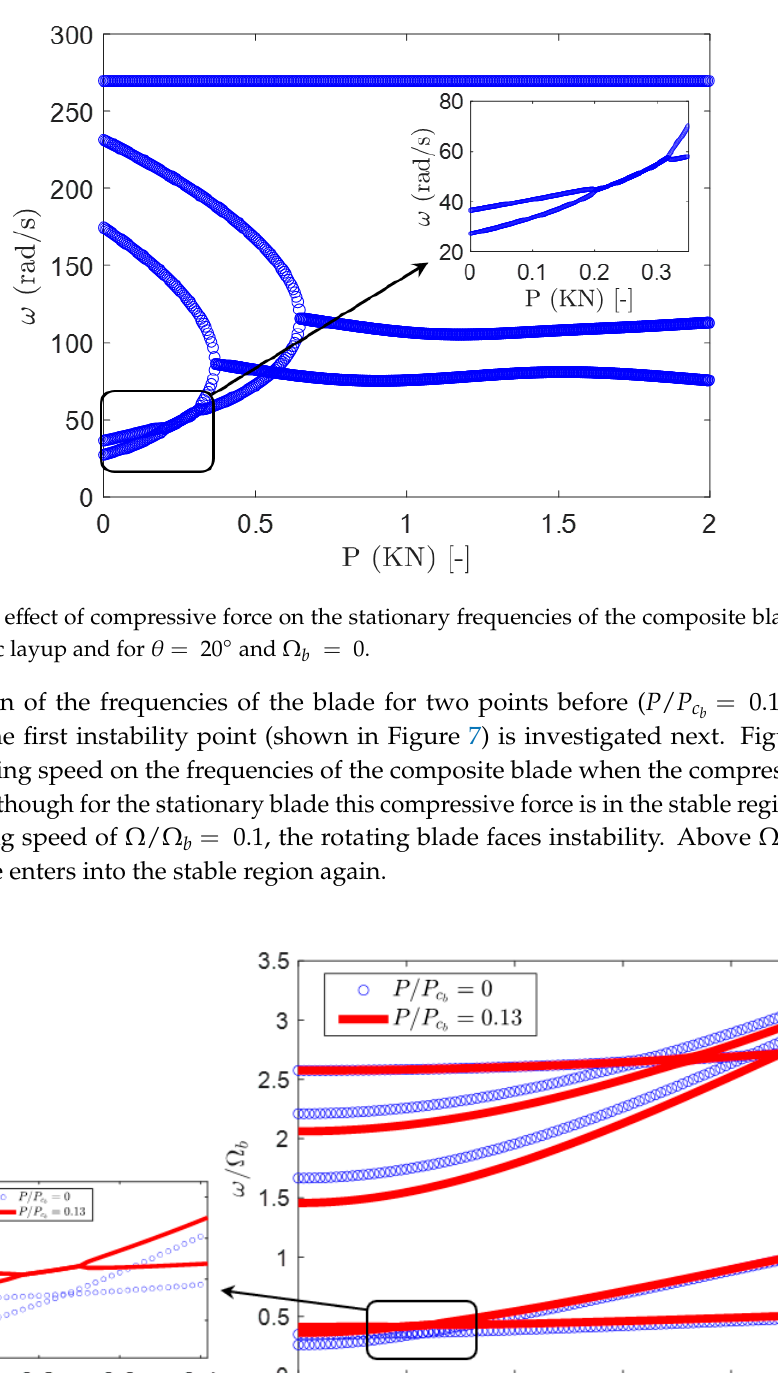
Figure 8. The effect of compressive force on the frequencies of the blade before the first instability point ( P/P c = 0.13) and for θ = 20 o . b